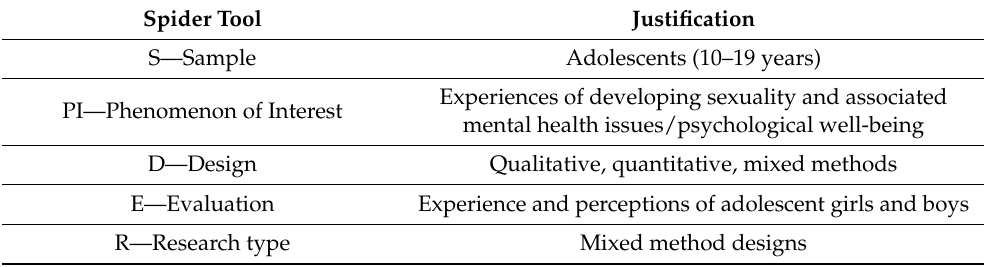
Table 1. Components of the Research Question using the SPIDER